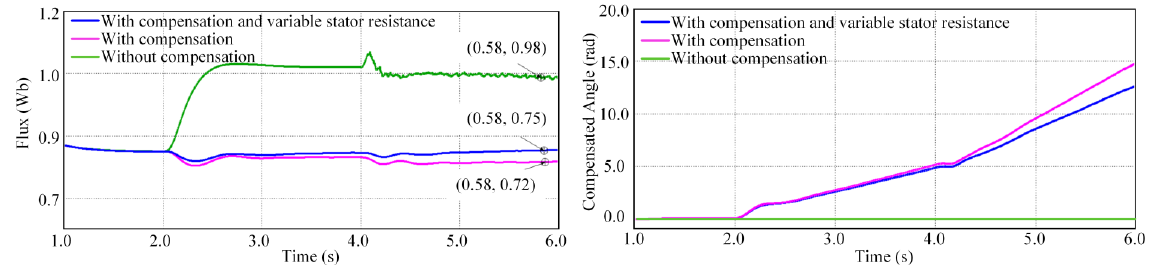
Figure 6. Rotor flux and compensated angle at 1200 rpm with the variable stator resistance. In the IRFOC, the q-axis current reflects the developed torque when the motor runs at a constant speed. Therefore, the q-axis current should be proportional to the torque. That is, the q-axis current with a 60 Nm load should be twice the value with a 30 Nm load at 1200 rpm. The q-axis current with different loads is presented in Figure 7. After compensation, the q-axis current is changed from approximately 15 A to 30 A when the load rises from 30 Nm to 60 Nm regardless of the R ∗ set. However, with no compensation, the q-axis current is different from the same load and is not proportional to the torque. The